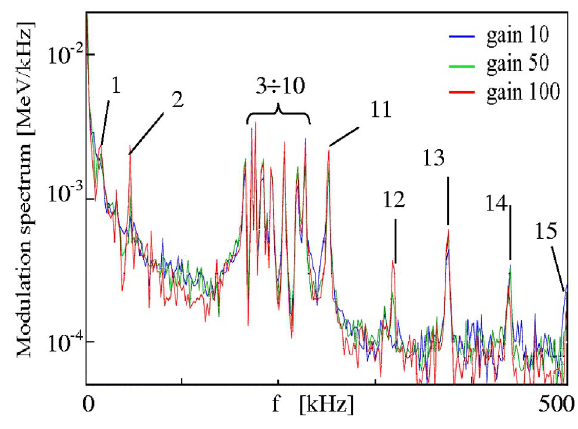
FIG. 8. (Color) Spectrum of the energy modulation as mea- sured at the end of the linac.